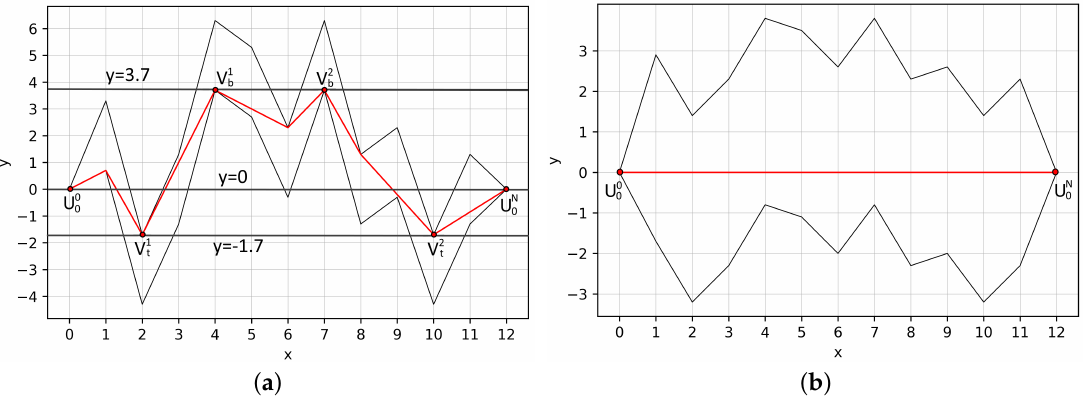
Figure 9. ( a ) Internal vertices of a balanced tube, which are global maxima and minima, curve L (red); ( b ) balanced tube with curve L without